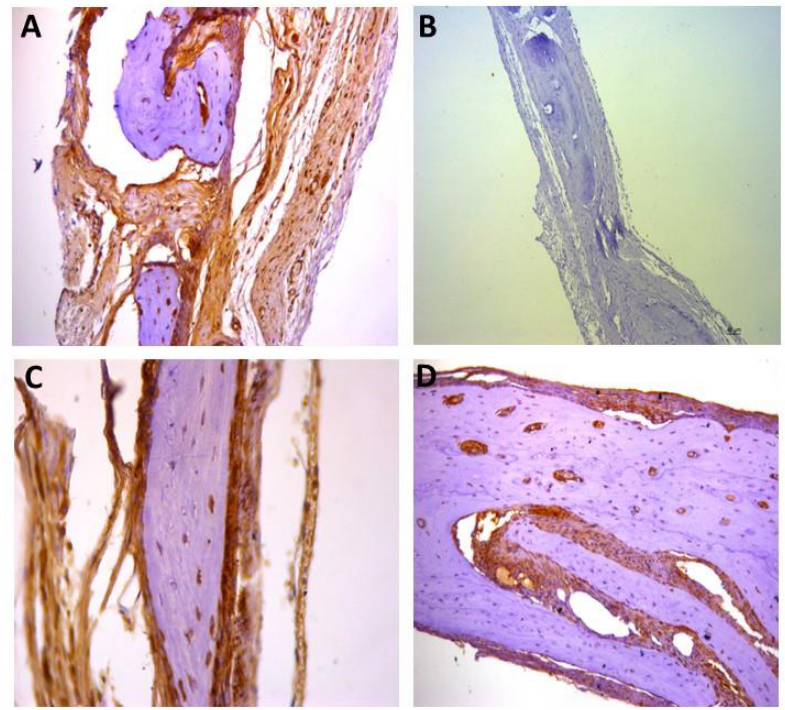
Figure 6. Representative immunohistochemistry images for IL6 staining. ( A ) control group; ( B ) negative control; ( C ) group 2 with marking considered (+++); ( D ) group 3 with marking considered (++++); the most observed staining pattern among the groups analyzed. Harris’ hematoxylin counterstained. Scale bar: 46 µ m.